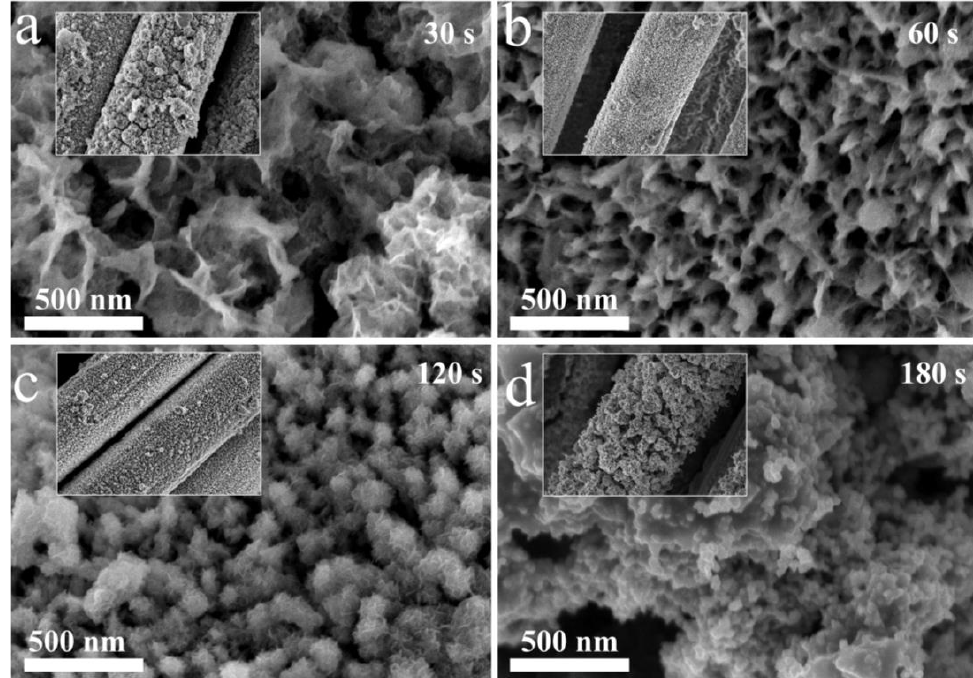
Figure 4. SEM images of D-Fe 2 O 3 @PPy/CC electrode prepared using different electrodeposition times: ( a ) D-Fe 2 O 3 @PPy-30 s, ( b ) D-Fe 2 O 3 @PPy-60 s, ( c ) D-Fe 2 O 3 @PPy-120 s, and ( d ) D-Fe 2 O 3 @PPy-180 s.